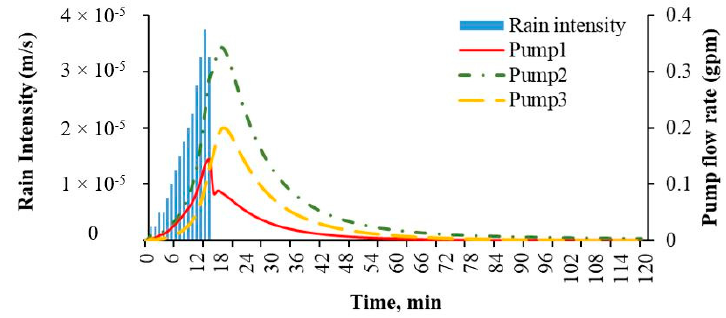
Figure 5. Pump flow rates as the output of the seepage analysis in a typical generated rainfall event (duration = 15 min, rainfall depth = 15 mm, and pattern “d”).